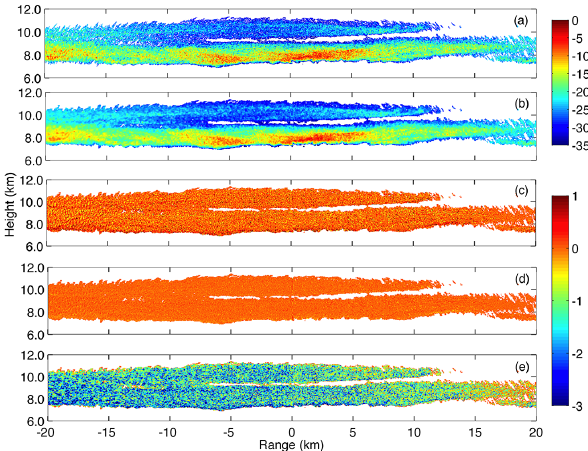
Fig. 5. Ka-SACR radar reflectivity 2-D gridding ( 1x = 50m, 1z = 50m) for a thick cirrus cloud observed at the ARM SGP site: (a) po- lar coordinates ( r,θ) Ka-SACR post-processed data; (b) x - z gridded radar reflectivity using the Barnes scheme; (c) difference in grid- ded radar reflectivity between the Barnes and Cressman schemes (dBZ BARNES − dBZ CRESSMAN ) ; (d) difference in gridded radar reflectivity between the Barnes and mean value schemes; and (e) difference in gridded radar reflectivity between the Barnes and max- imum value